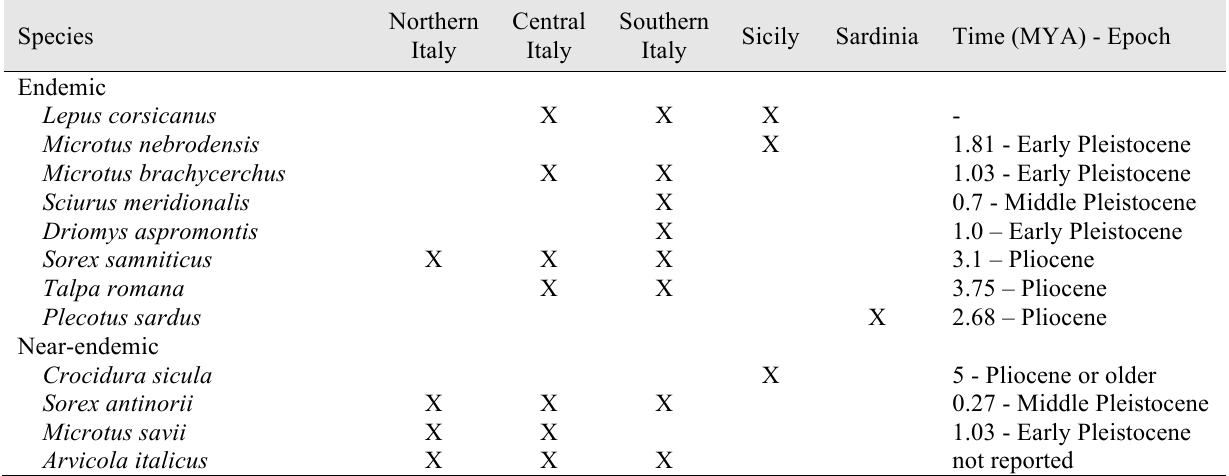
Table 1. Distribution and origin of the endemic and near endemic species to the Middle Pleistocene and Pliocene based on phylogenetic studies applying a molecular clock. Species